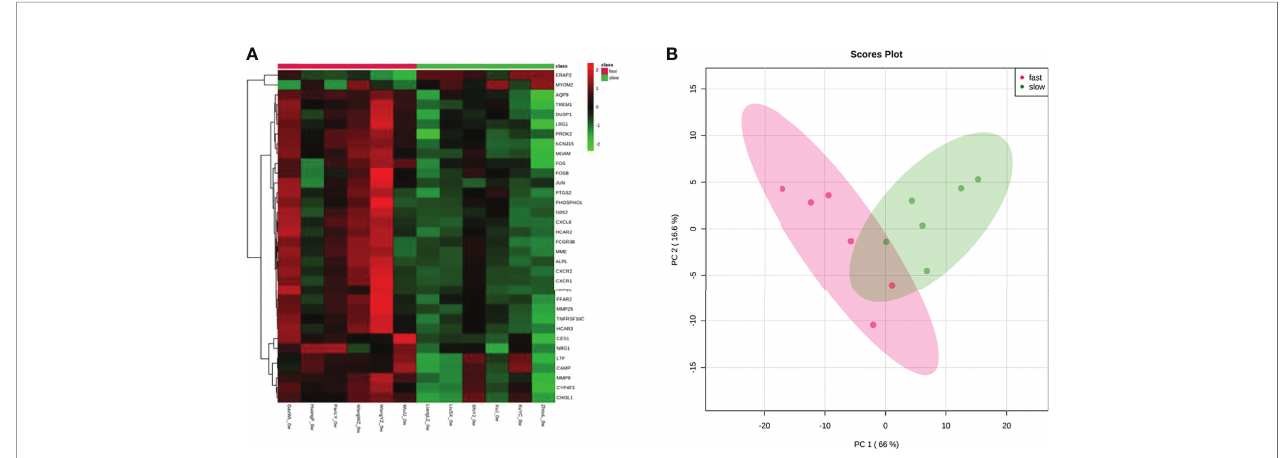
FIGURE 3 | Assessment and visualization between fast responders and slow responders. (A) A heat map was generated from unsupervised clustering of differentially expressed transcripts between fast responders and slow responders. For clarity, the 79 transcripts with-1.5>log2(FC)>1.5, and p<0.05 were selected. Green indicates low expression levels whereas red indicates high expression levels. (B) PCA plots after the batch effect